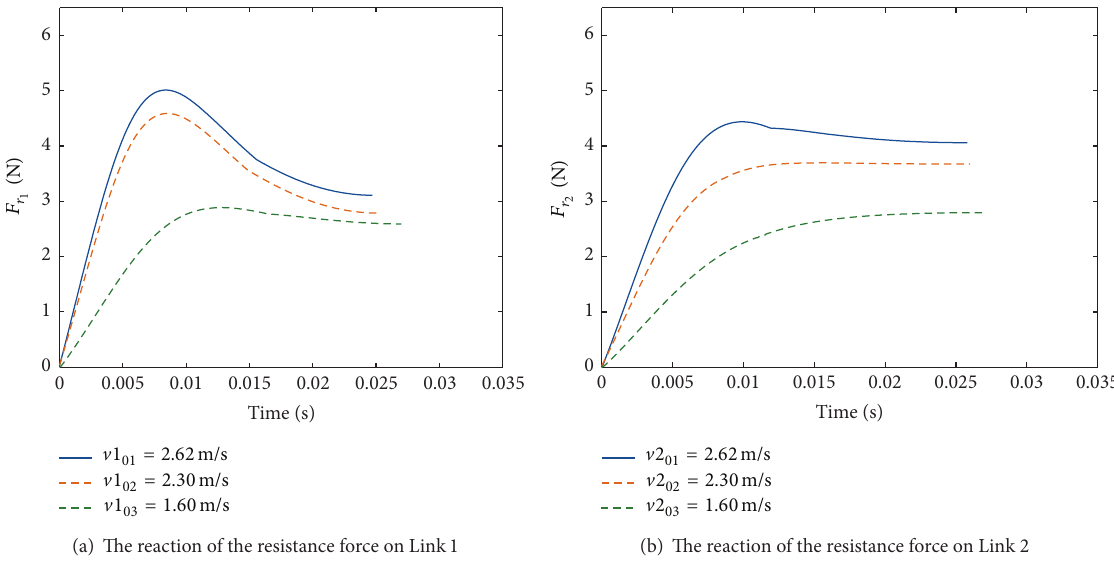
Figure 5: The resistance force during penetration phase on the impacting system: (a) for Link 1 with impact angle 𝑞 1 = − 15 ∘ , and (b) for Link 2 with impact angle 𝑞 2 = 15 ∘